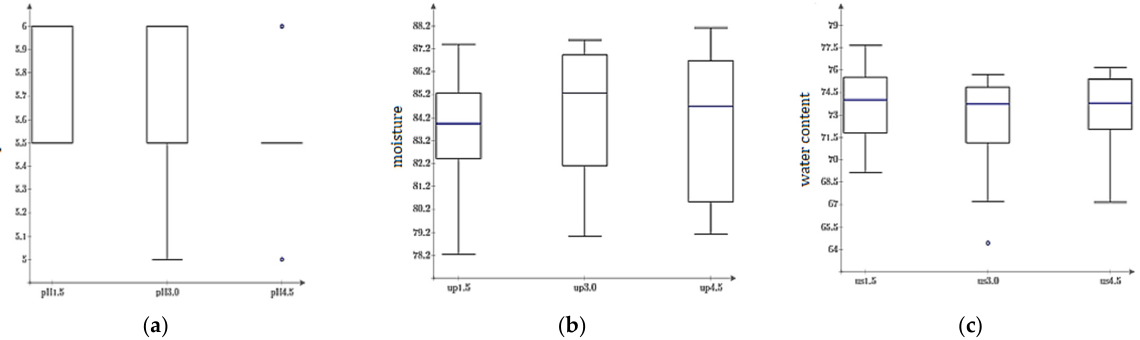
Figure 1. Box plot representations of the distribution of pH ( a ), soil moisture ( b ), and plant water content ( c ), during the experiment, for the three cases of soil contaminated with a solution of 1.5%, 3.0%, and 4.5% zinc concentration.